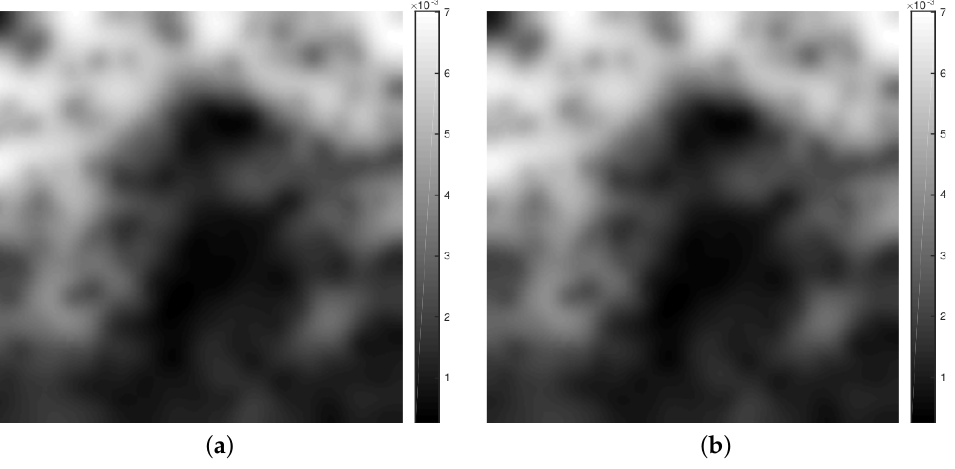
Figure 9. Spatially varying regularization parameter generated by the respective pLATV-algorithm. ( a ) pLATV with pdN with η = 0; ( b ) pLATV-algorithm with box-constrained